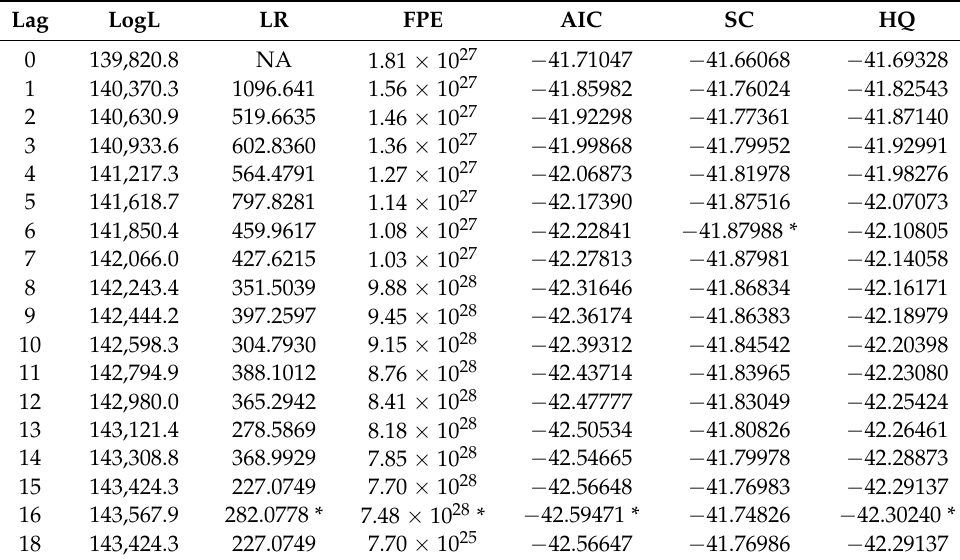
Table A2. VAR lag order selection